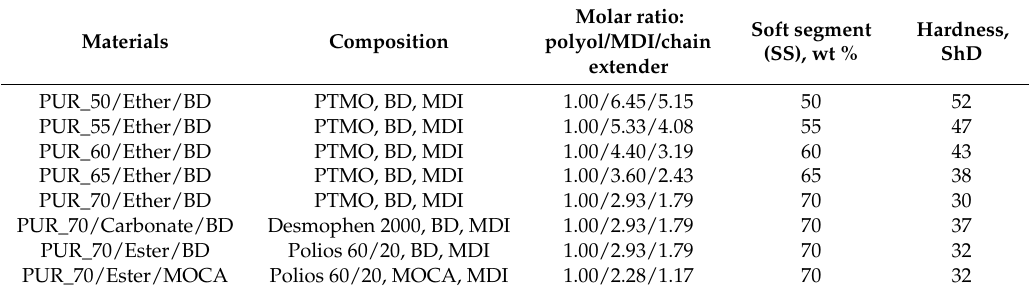
Table 2. Summary of the prepared polyurethane elastomers’ (PUR) chemical composition and hardness, and the reactants’ molar ratio.